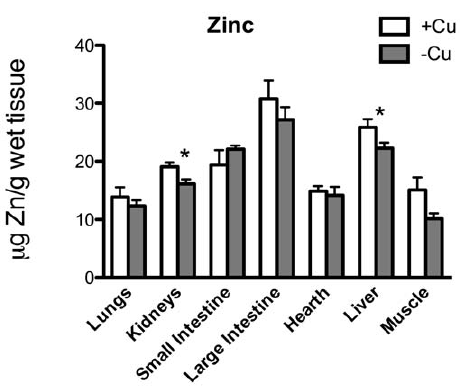
Figure 4. Zn content. Zn ( m g/g wet tissue) in the lungs, kidneys, small intestine, large intestine, heart, liver, and muscle. * p , 0.05.